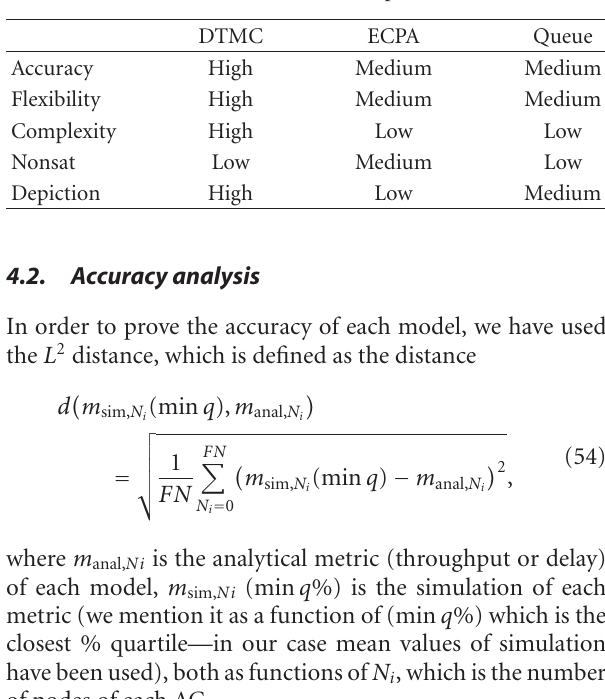
Table 4: Metamodel comparison.